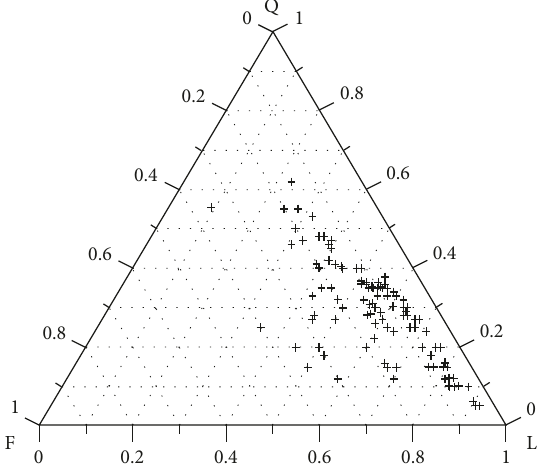
Figure 4: Ternary plot showing sandstone compositions according to Folk’s (1980) classification